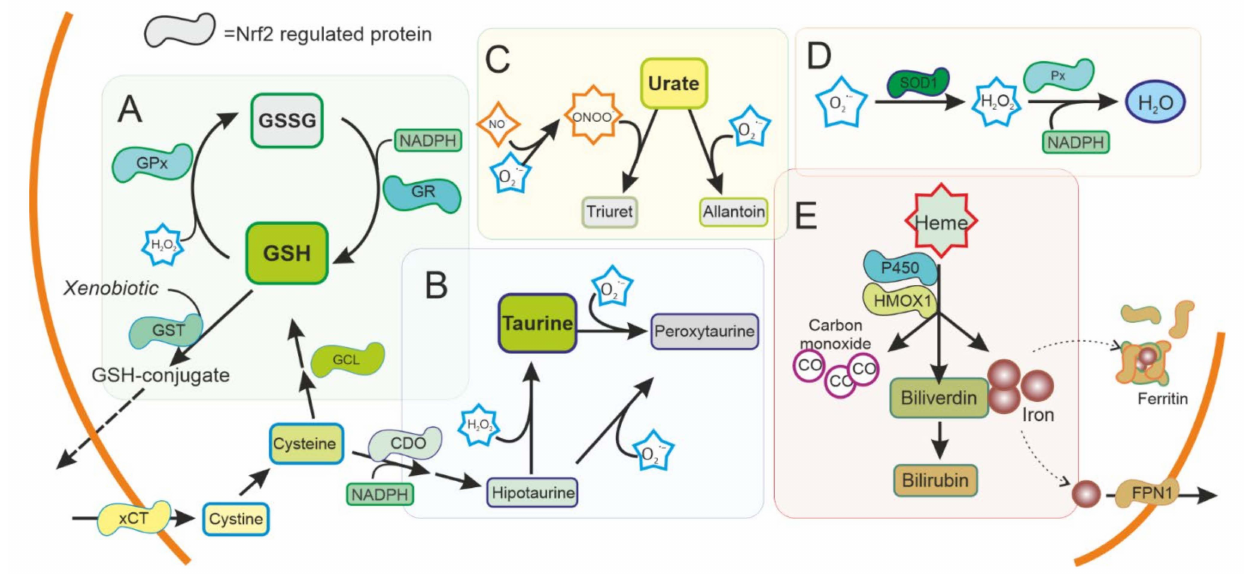
Figure 2. Antioxidant system regulated by NRF2 in the cytoplasm. ROS production is used as a signal molecule and is a byproduct of several reactions in cells that can result in oxidative stress. Cells can use ROS scavengers such as ( A ) glutathione (GSH), ( B ) taurine, ( C ) urate, as well as detoxifying enzymes as ( D ) superoxide dismutase (SOD), peroxidase (Px), ( E ) Heme oxygenase 1 (HMOX1), or cytochrome P450, present in the cytoplasm to reduce ROS and toxic metabolites. NRF2 is regulating and can be regulated by these pathways. GSH: Reduced glutathione. GSSG oxidized glutathione. GST: Glutathione S Transferase. GPx: Glutathione peroxidase. GR: Glutathione reductase. xCT: Cystine-Glutamate exchanger. GCL Glutamate-cysteine ligase. CDO Cysteine dioxygenase. SOD1: Superoxide dismutase type 1. FPN1: